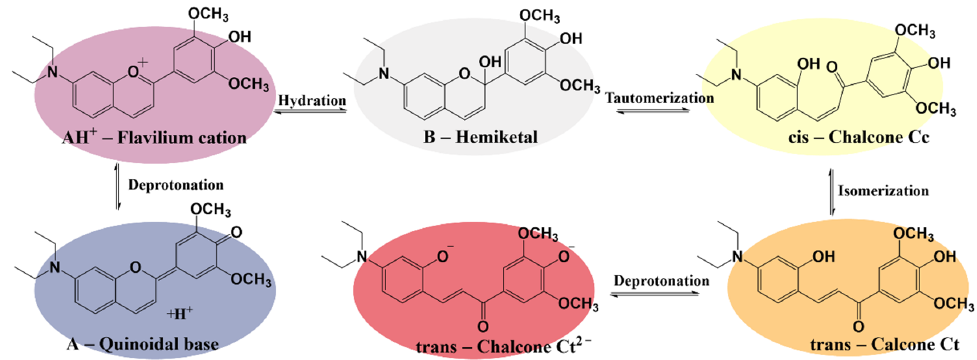
Figure 3. The network of reversible chemical reactions of the bio-inspired dye species upon pH